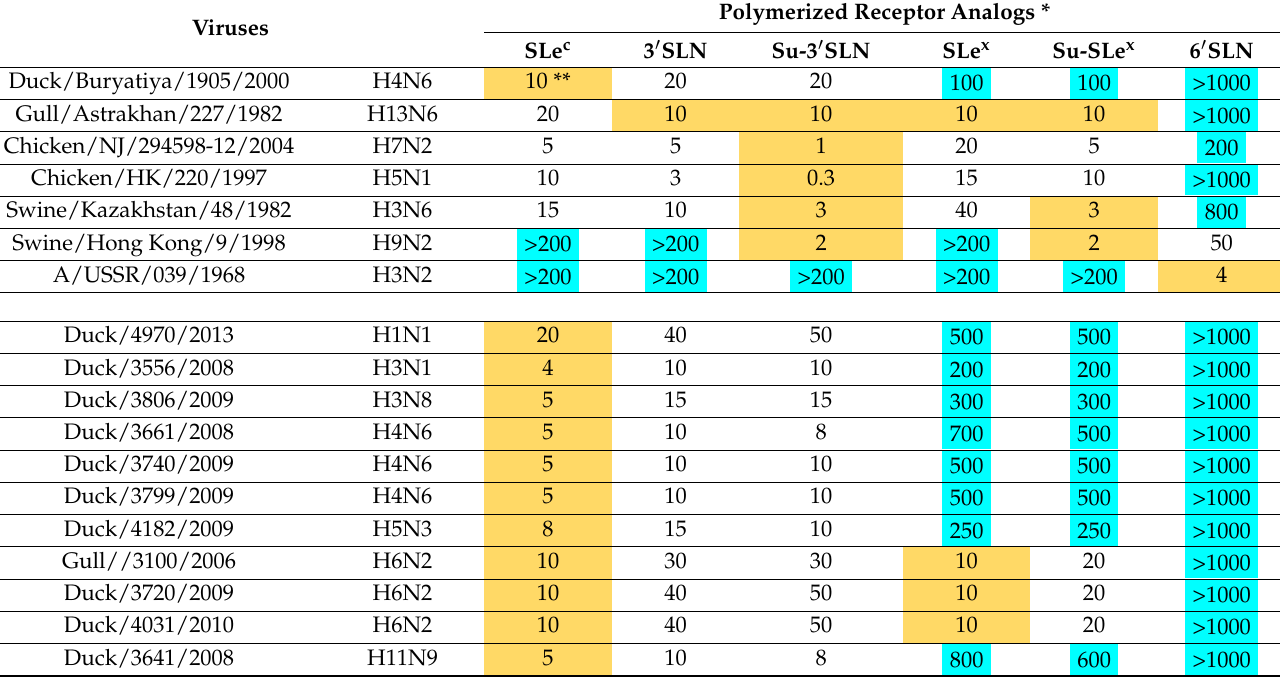
Table 3. Concentration of sialoglycoconjugates provided 50% inhibition of binding viruses with HRP-labeled